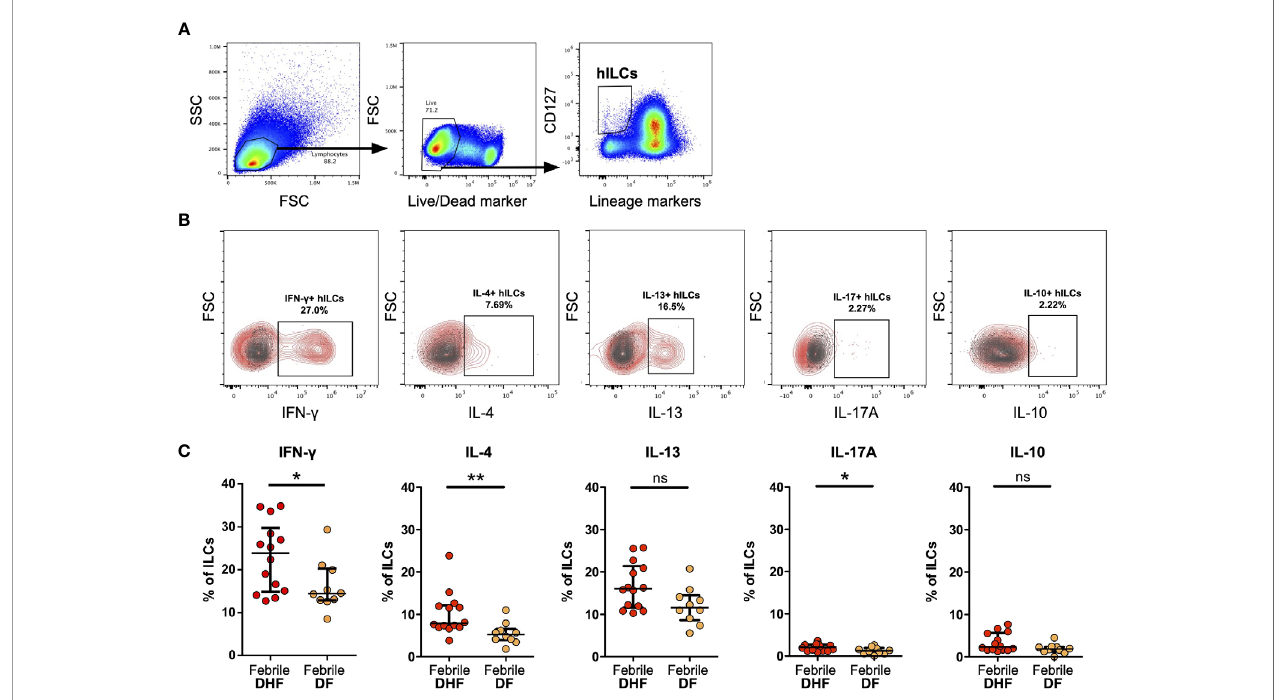
FIGURE 3 | Intracellular cytokine staining of hILCs from febrile DF and DHF after PMA/ionomycin ex vivo stimulation (A) Flow cytometry analysis gating strategy of total hILCs from PBMC. (B) Representative contour plots of IFN- g , IL-4, IL-13, IL-17A, and IL-10 expression (red) overlaid on FMO control (grey). (C) Percentage of IFN- g , IL-4, IL-13, IL-17A, and IL-10 expression of hILCs in febrile phase of DF and DHF patients. The results were presented as median ± IQR. Data were analyzed using Mann-Whitney test (*p < 0.05, **p < 0.01; ns, not signi fi